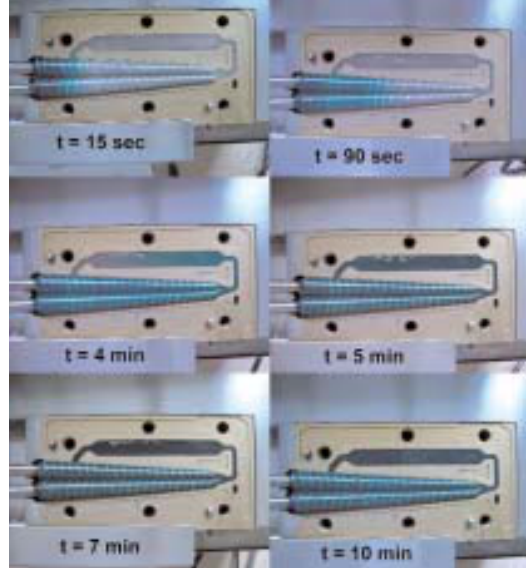
Figure 4: Asaclean 6.96 g Remafin green MB (T = 220˚C, 50 rpm).